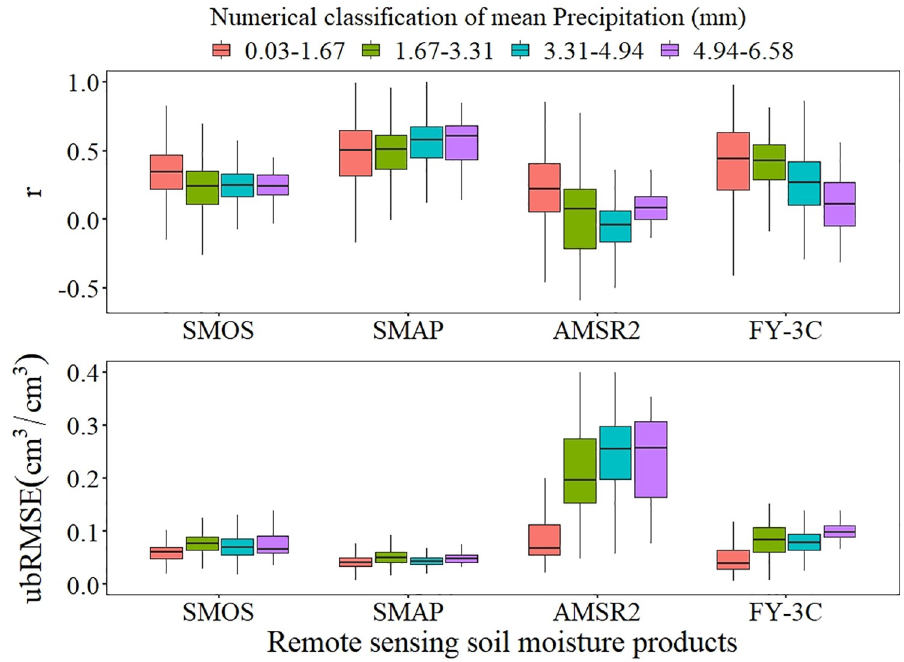
Fig 8. Boxplots of precipitation condition for r and